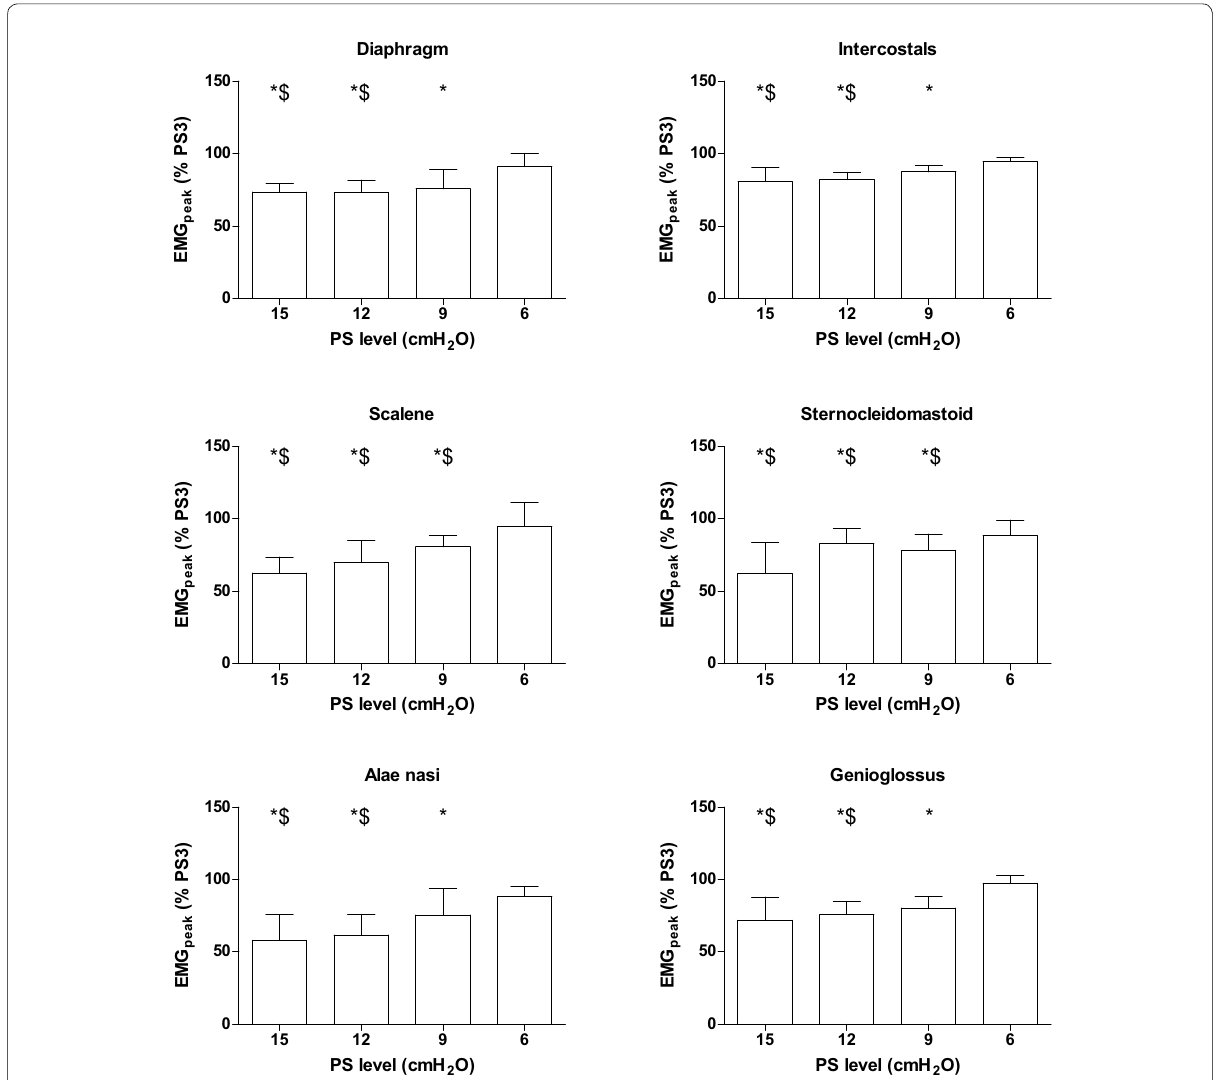
Fig. 1 Extradiaphragmatic inspiratory muscle activity increases when lower support levels are applied ( P < 0.05). The peak electromyography (EMG peak ) values are normalized to activity at 3 cmH 2 O pressure support (PS). Values are represented as median (interquartile range). The number of subjects in which EMG parameters could be determined differed per muscle and PS level. Globally, for the alae nasi N 14, genioglossus N = = 10, scalene N 16, sternocleidomastoid and diaphragm N 17, and parasternal intercostals N 15. *Significant difference with PS 3, $ significant = = = difference with PS 6 ( P <